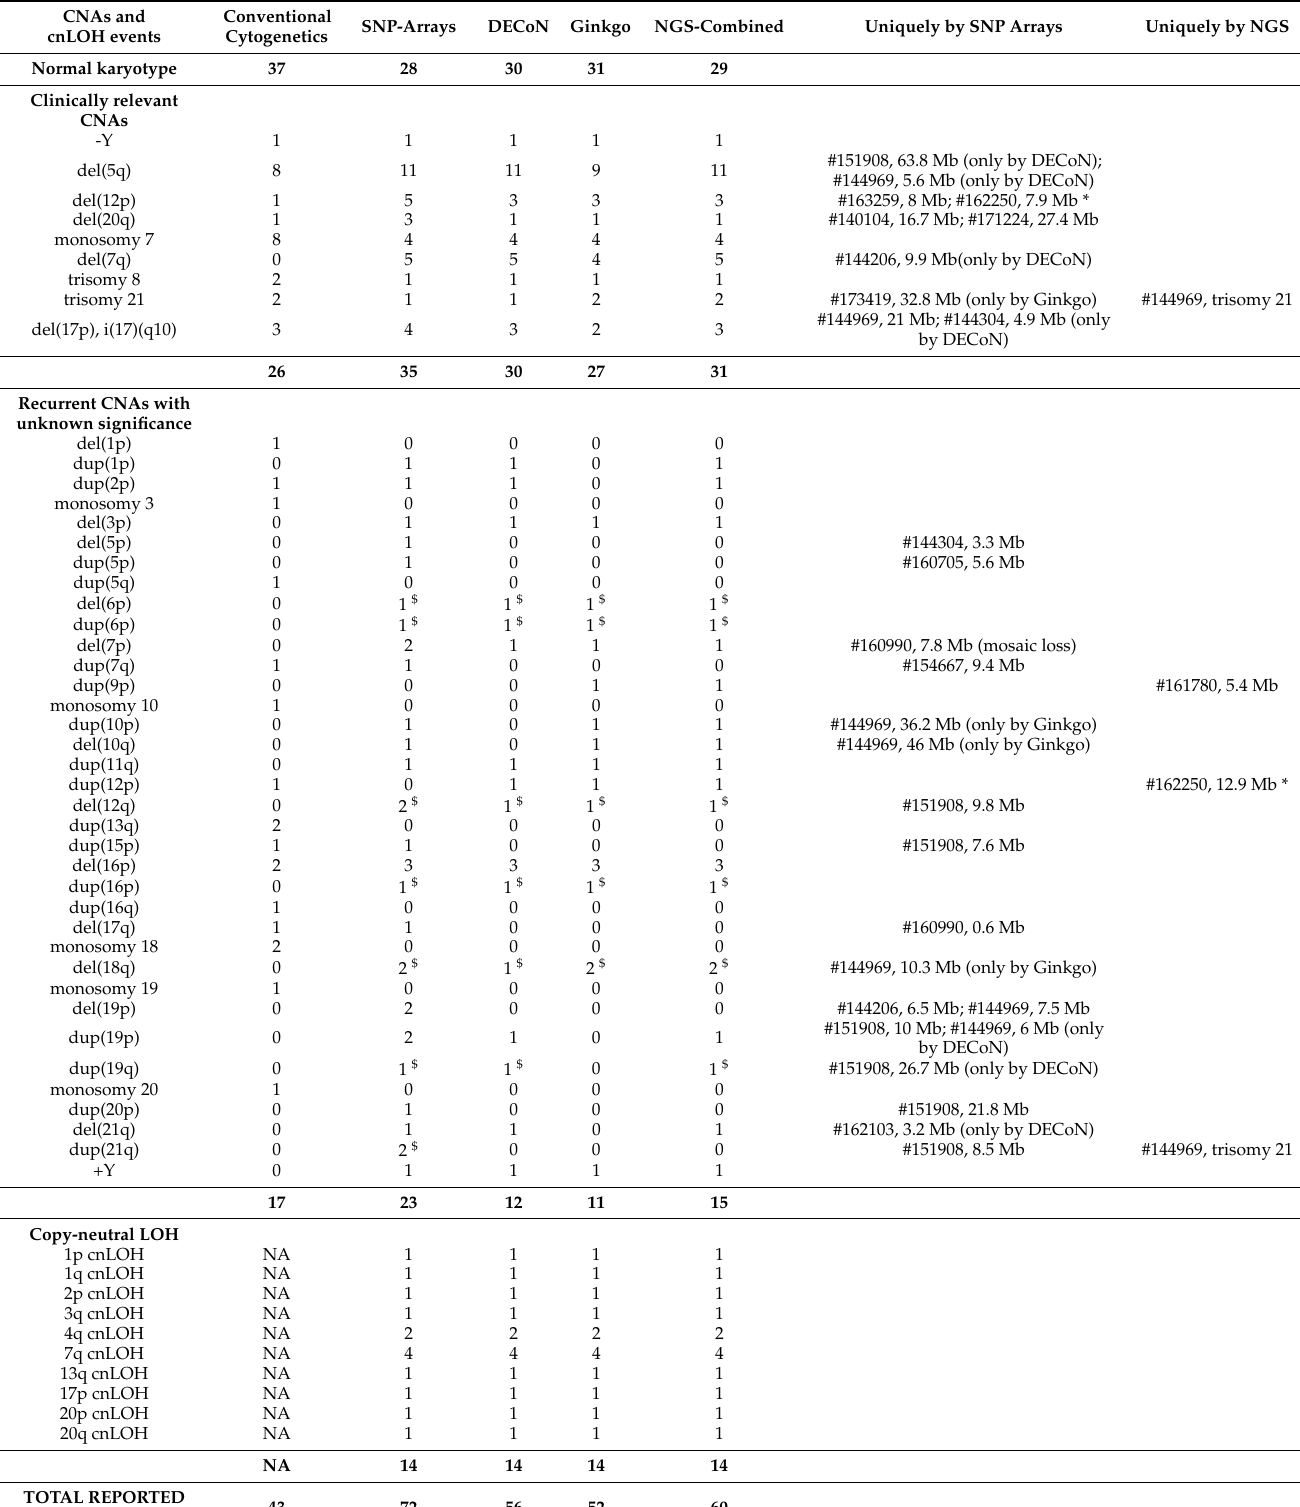
Table 2. CNA and cnLOH events identified by using three different